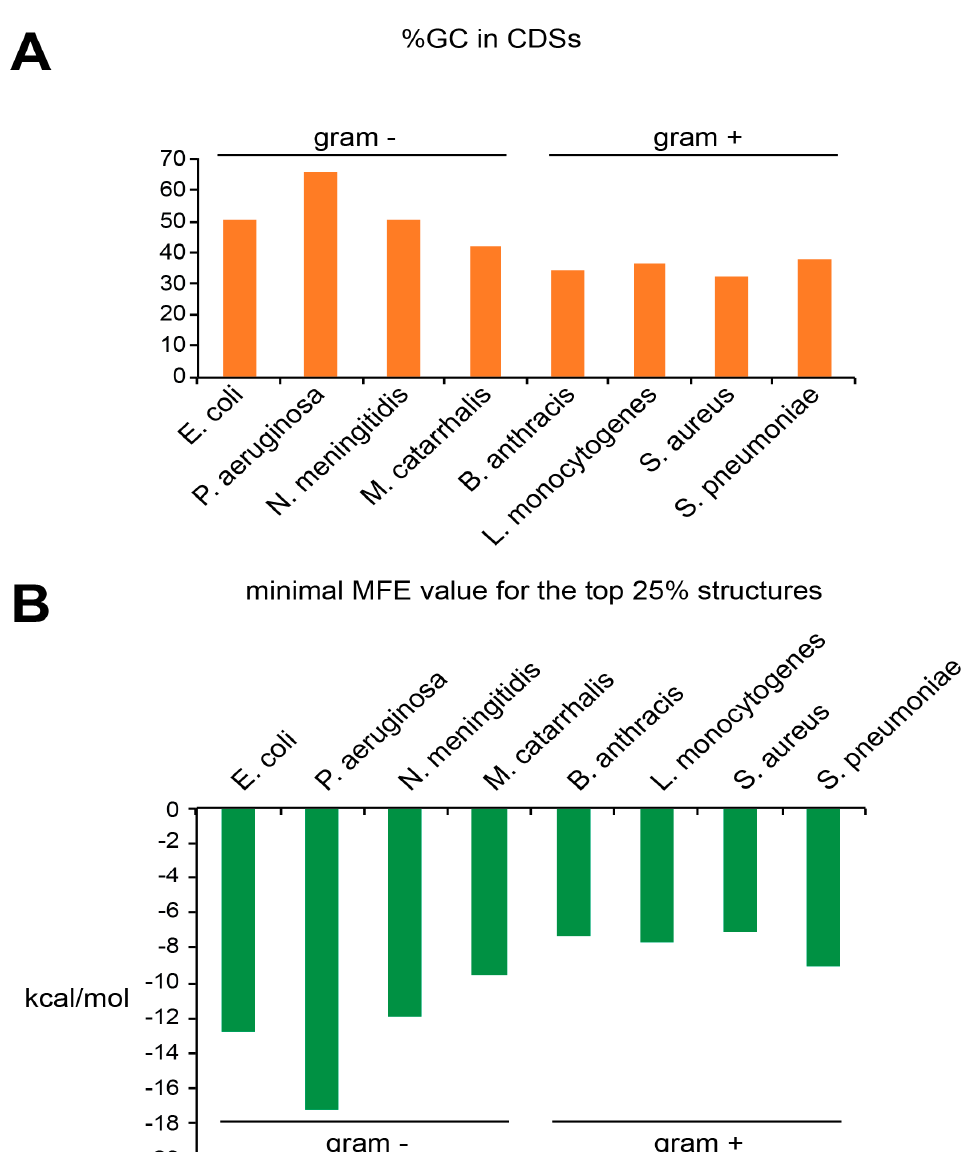
Figure 5. ( A ) The histogram represents the percentage of GC in the analyzed CDSs in Gram-negative and Gram-positive bacteria. ( B ) The histogram represents the lowest minimal free energy of the top 25% of the structures found the analyzed CDSs from Gram-negative and Gram-positive bacteria.